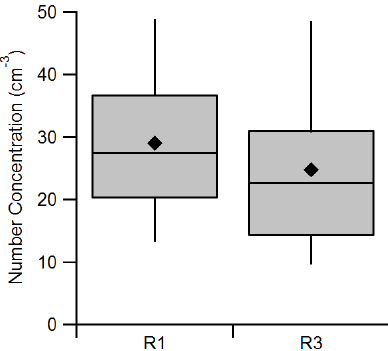
Fig. 14. Aerosol number concentrations (0.1 <D p < 3µm) from the PCASP measured above (R1) and below (R3) the supercooled layer cloud. Whiskers extend to 5th and 95th percentiles, boxes encom- pass 25th to 75th percentiles and 50th percentiles are horizontal lines. Mean values are represented by black